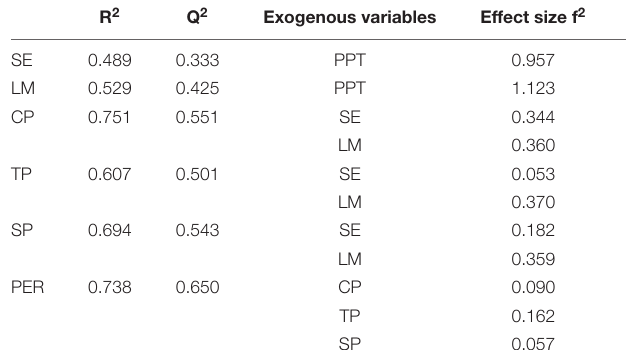
TABLE 7 | Predictive relevance and effect